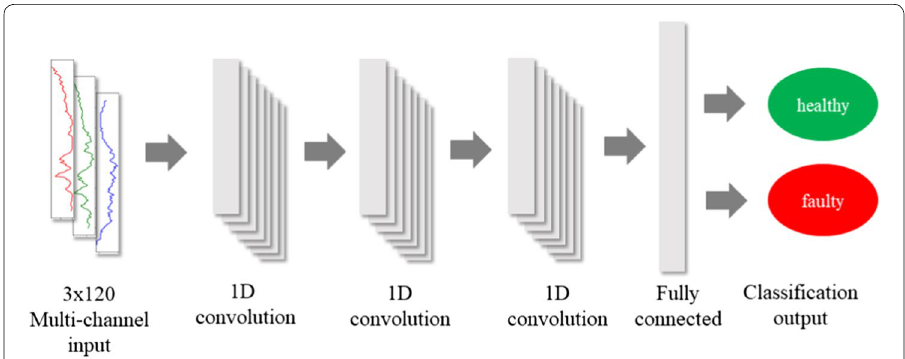
Fig. 8 Convolutional neural network architecture for machine